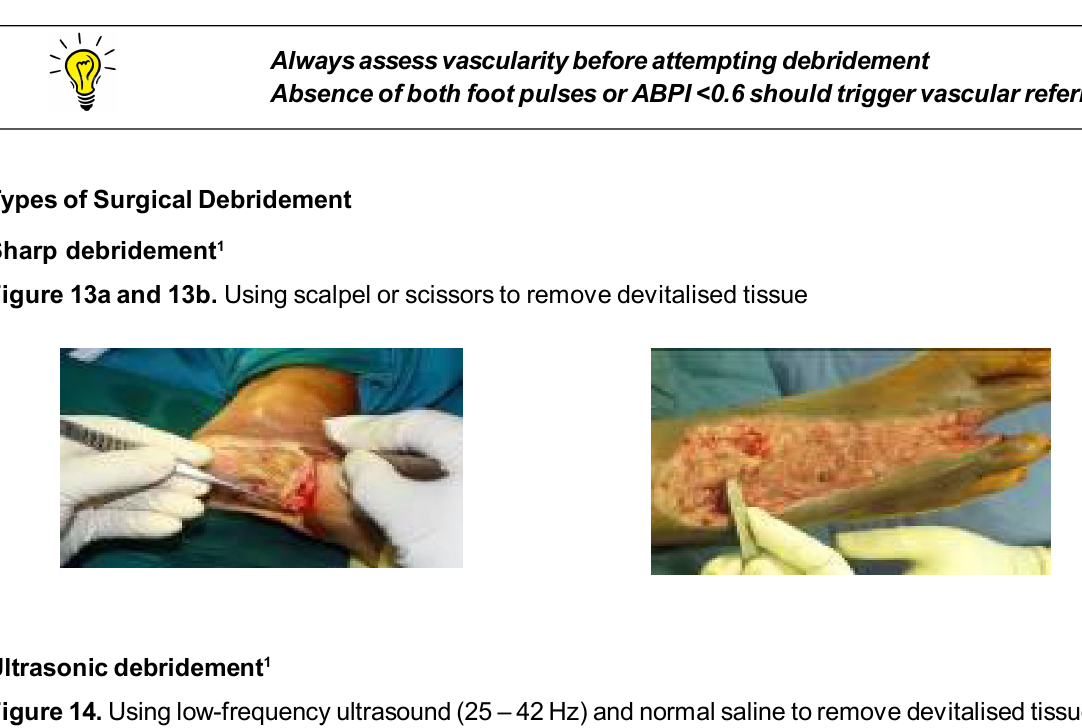
Figure 14. Using low-frequency ultrasound (25 – 42 Hz) and normal saline to remove devitalised tissue